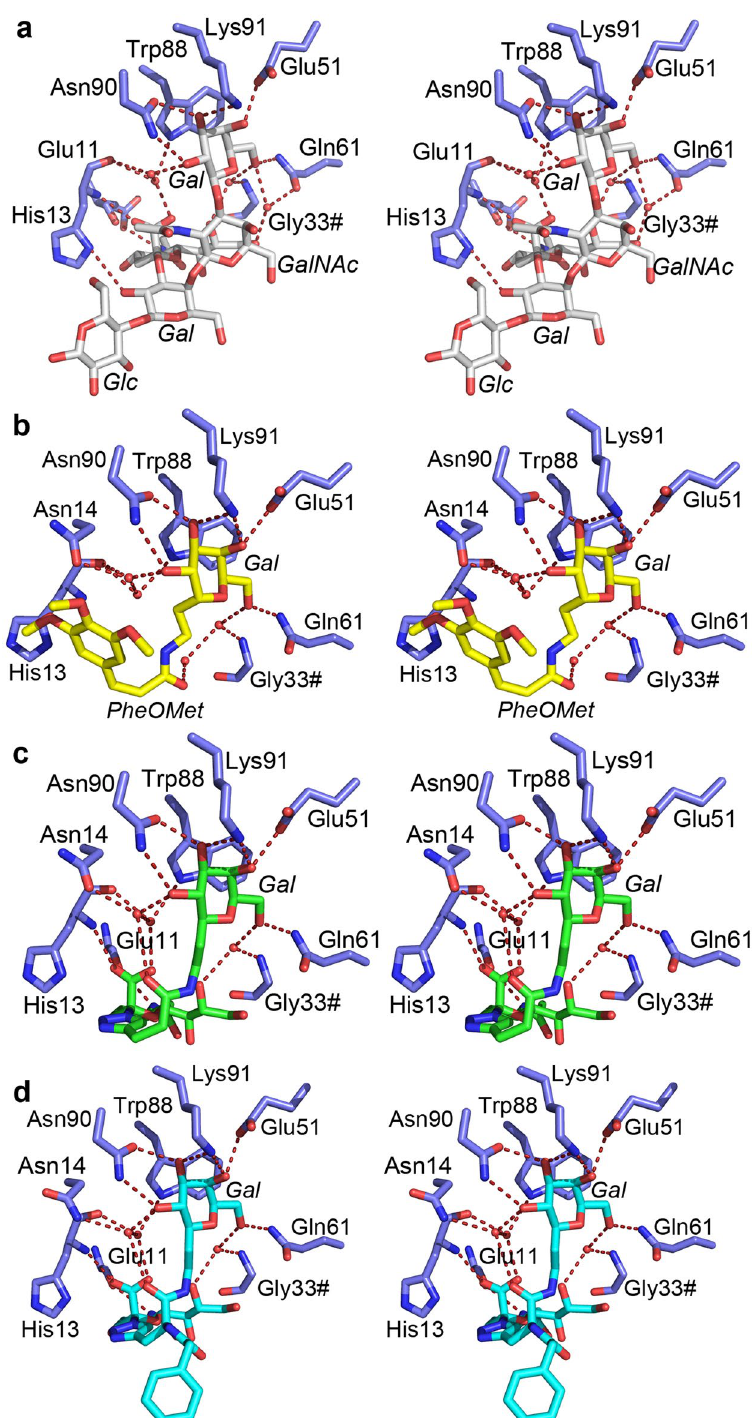
Figure 3. Stereoimages of the detailed carbohydrate-toxin interactions. Relevant amino acids are shown as blue sticks and labelled. Residues from neighbouring subunits are indicated with a hash (#). Water molecules are shown as red spheres, and hydrogen bonds by red dashed lines (restricted to bond lengths less than 3.6 Å, and with favourable angles). Carbohydrate residues are labelled in italics. Shown are toxin complexes with ( a ) GM1-os (white sticks; PDB ID 3CHB 20 ), ( b ) 1 (yellow sticks), ( c ) 2 (green sticks), and ( d ) 3 (cyan sticks). All ligands bind to the same binding site, b-d show structures solved in this work. The figure was prepared with MacPyMol (Schrödinger LLC (www.schrodinger.com/pymol); version